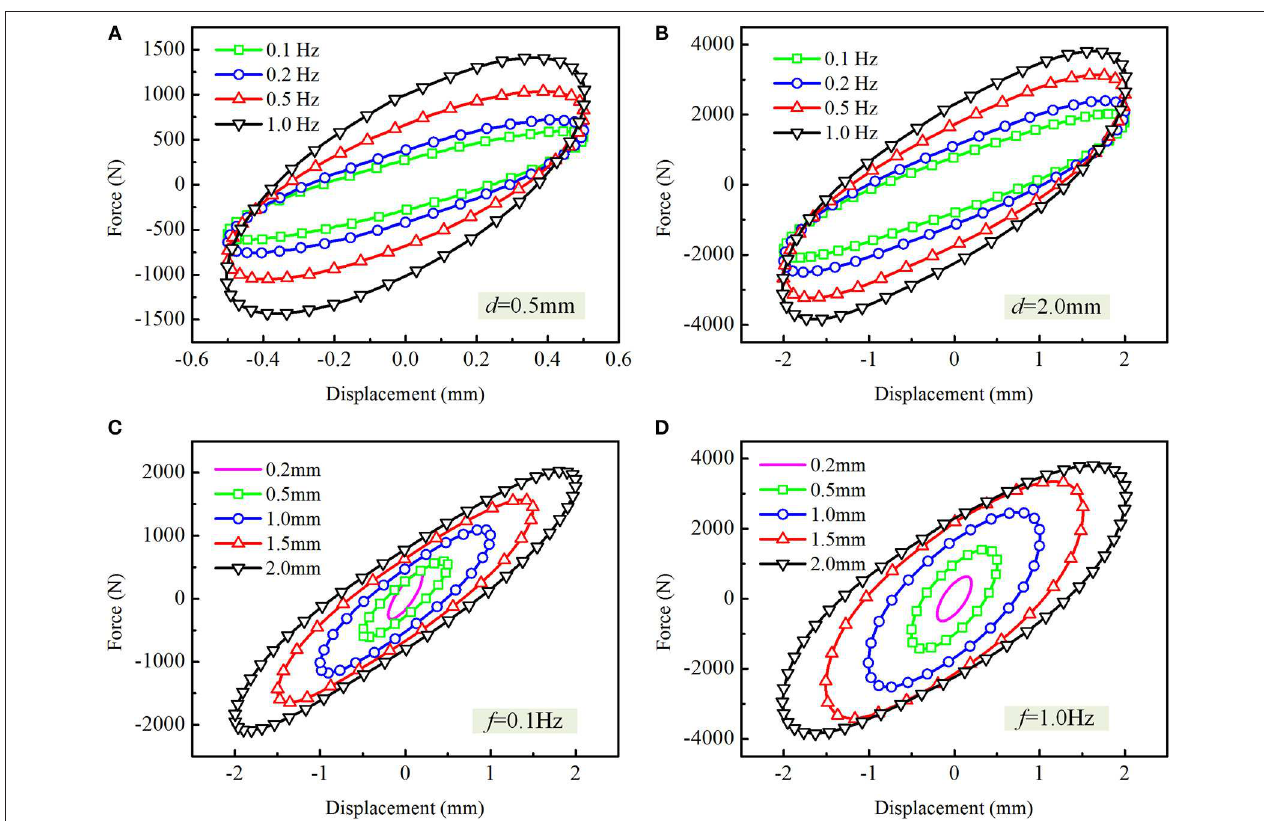
FIGURE 3 | The representative force-displacement hysteresis loops of the viscoelastic damper. (A–D) d = 0.5mm, d = 2.0mm, f = 0.1Hz, and f = 1.0Hz, respectively.